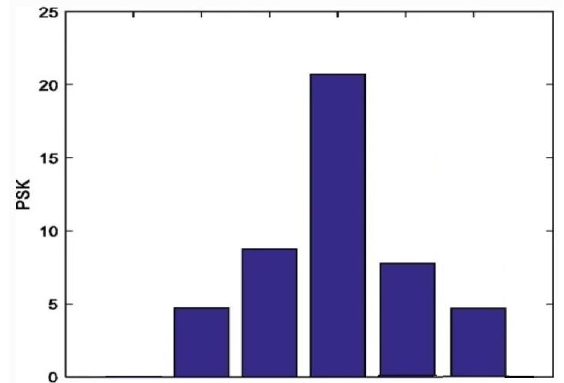
Figure 12. Result of optimal characteristic sub-band selection.